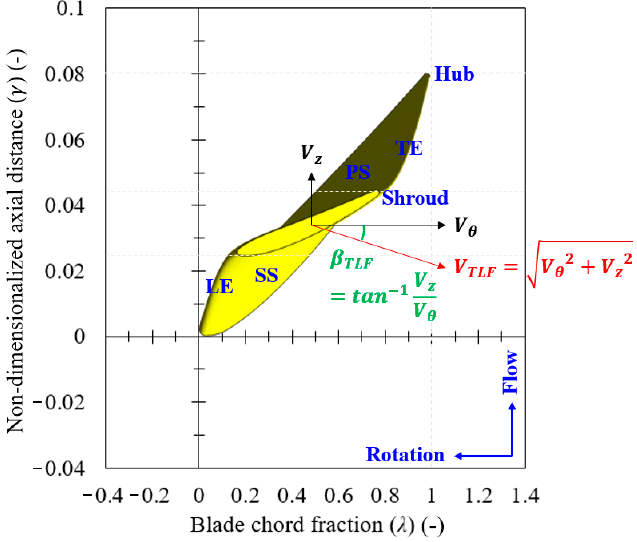
Figure 16. Expressions for the location of the blade and the velocity of tip leakage flow on a two-dimensional plane.